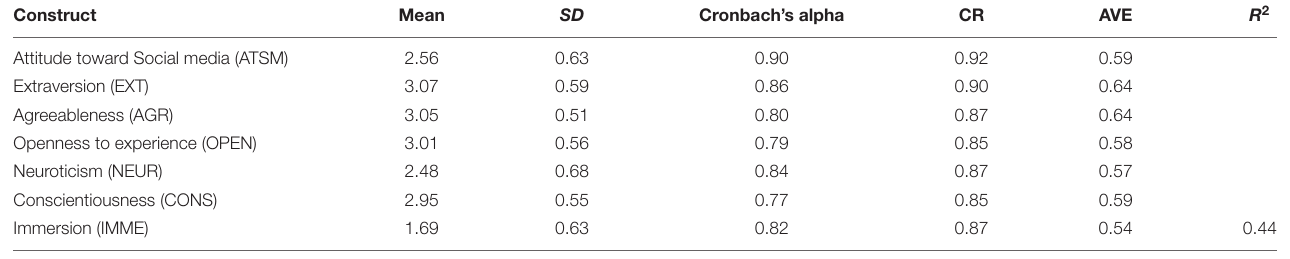
TABLE 3 | Correlation matrix and square root of the AVE.